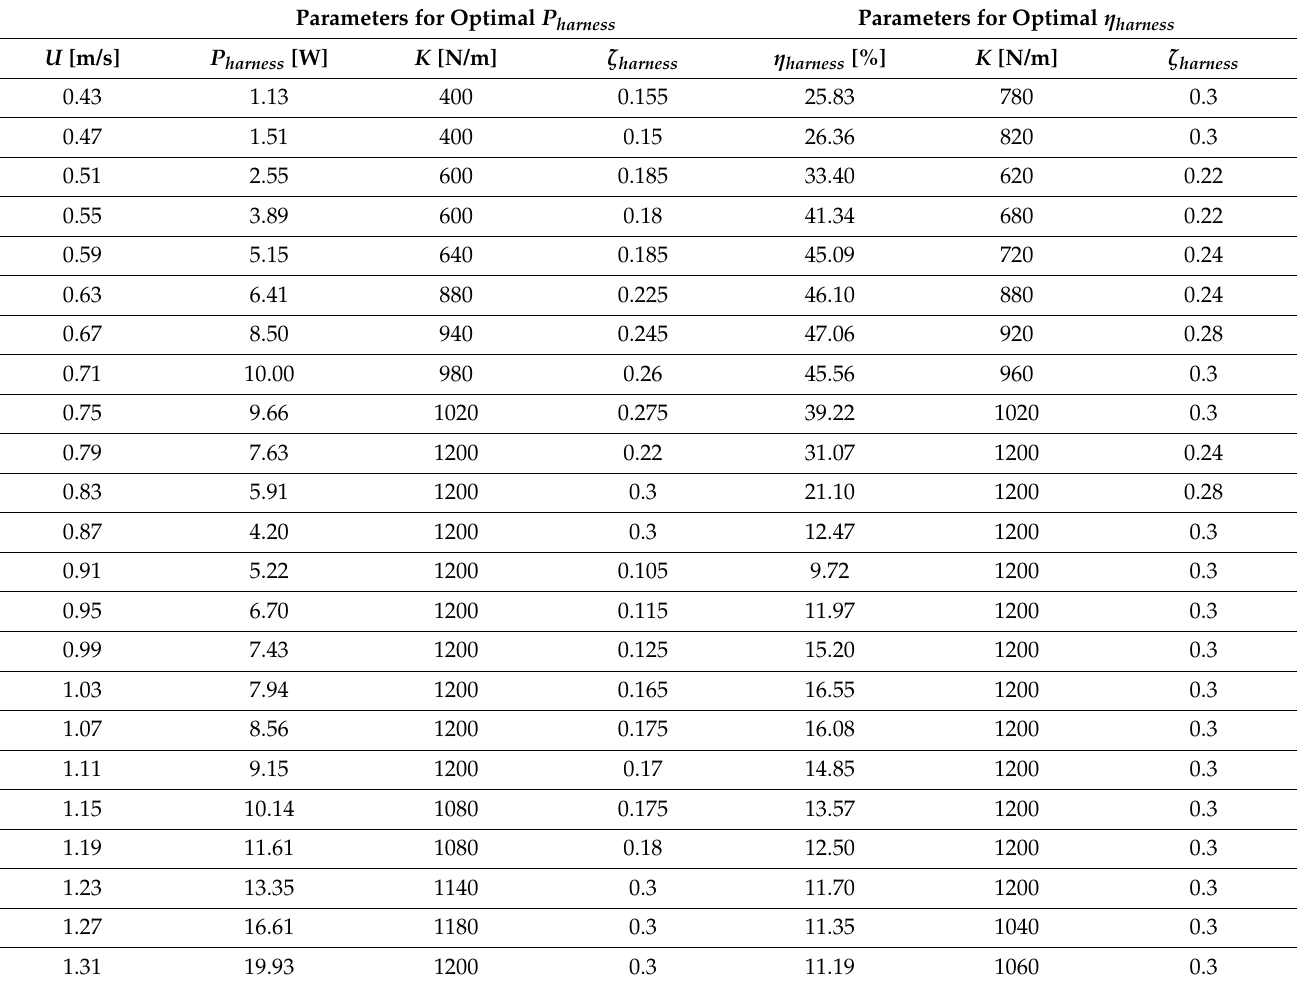
Table A3. Parameters of optimal harnessed power and efficiency for single cylinder. Parameters for Optimal P